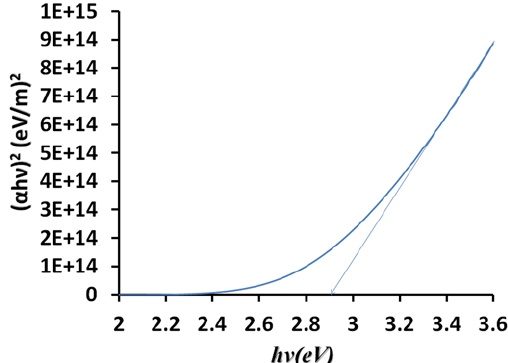
Fig. 6. Tauc’s plot of (αhν) 2 vs the photon energy for the Ge colloidal Fig. 6.